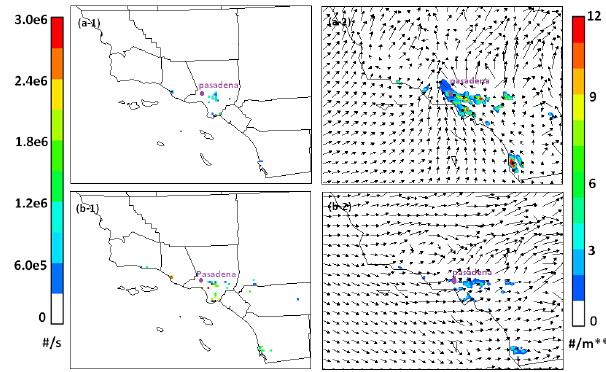
Fig. 7. Simulated olive emissions (left panel) and pollen plumes with wind vector overlays (right panel) on April 12, 2010 (a) at midnight PST when Pasadena was affected; and (b) at 3:00 pm PST when Pasadena, CA was not affected.